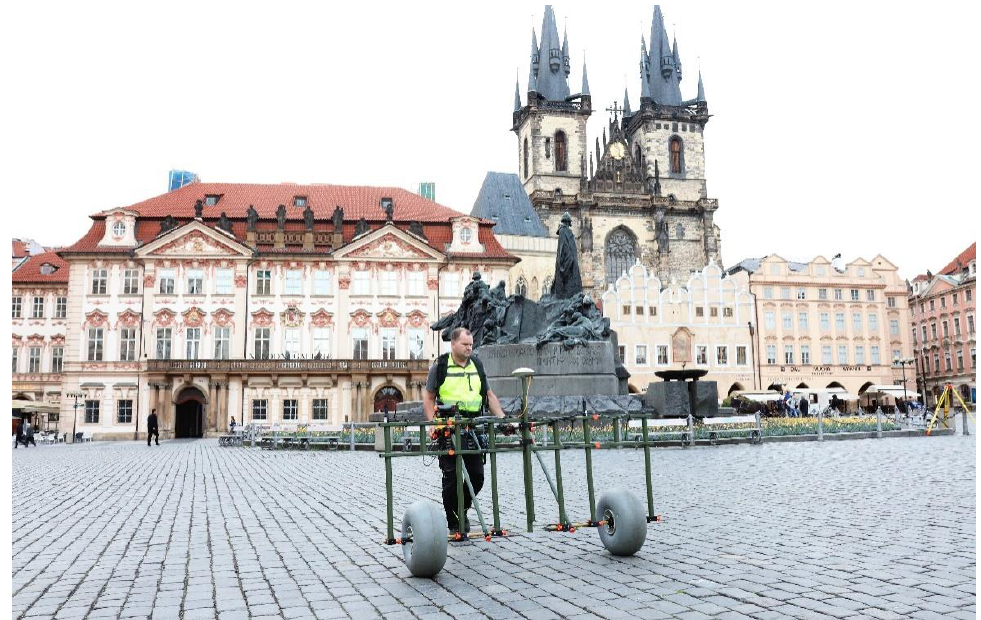
Figure 3. The Old Town Square, monument of Jan Hus, Church of Mother of God before Týn and in foreground the Magneto MXPDA magnetometry system (Sensys).